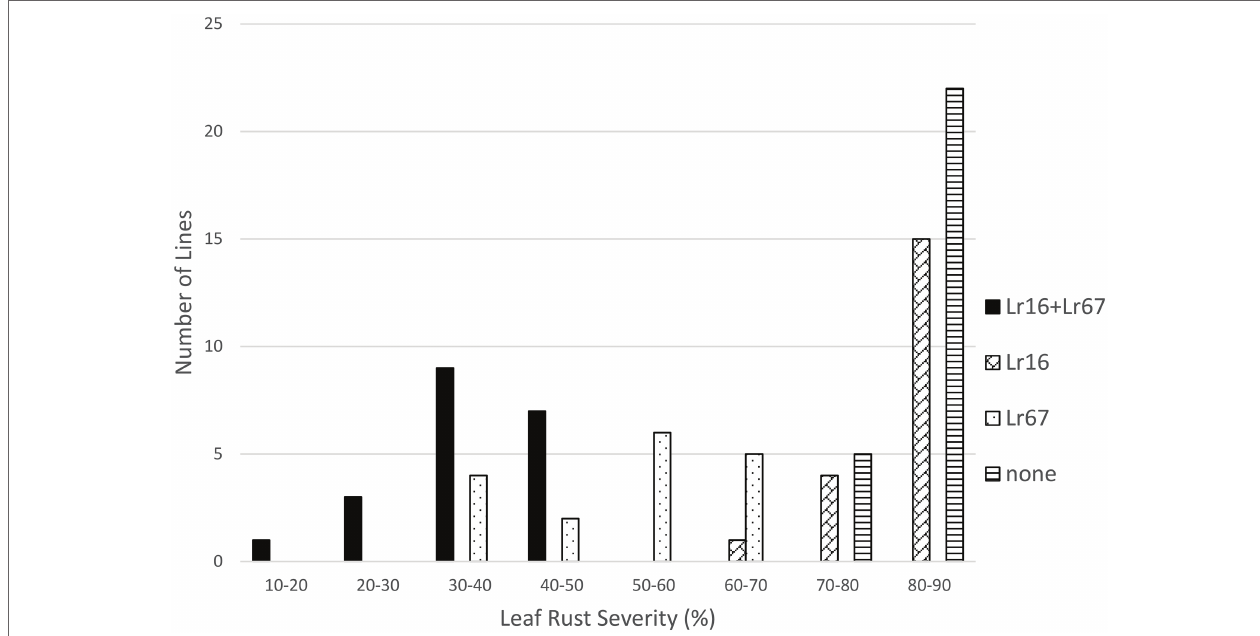
FIGURE 4 | Average leaf rust field severity (2012–2015) for progeny lines from the cross Lr16 / Lr67.